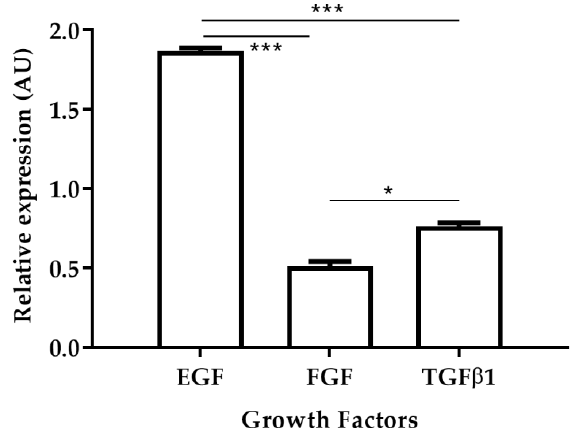
Figure 4. Relative expression of growth factors EGF, FGF and TGF β 1 after treatment with Arnica tincture. The figure shows the induction of growth factors calculated by the ΔΔCT methods between